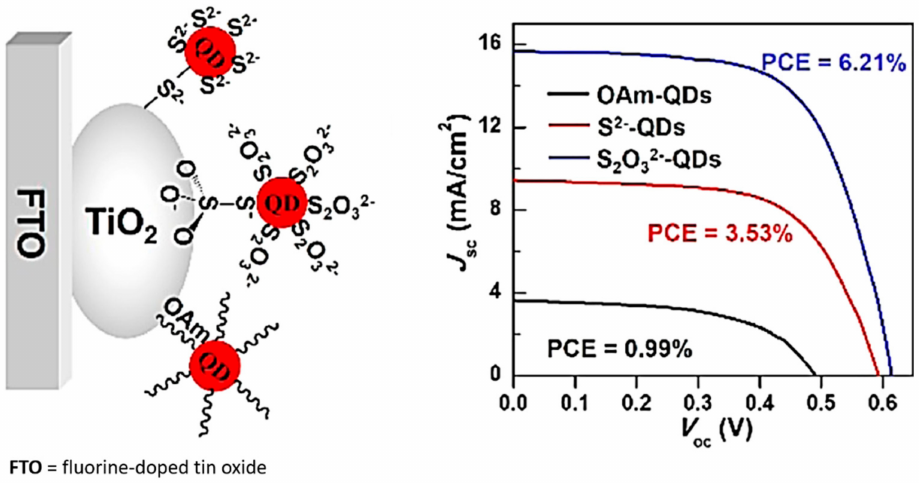
Figure 11. Scheme of a CdSe QD-sensitized solar cell (QDSC) and J-V curves for oleylamine, S 2 − , and S 2 O 32 − -capped CdSe QDs-based QDSCs (FTO is fluorine-doped tin oxide glass). Reprinted with permission from [76]. Copyright 2017, American Chemical